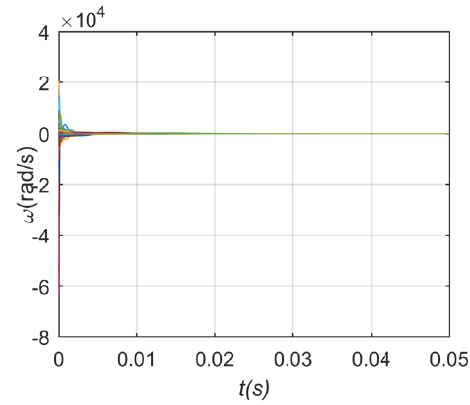
Figure 22. Frequency stabilization process in case